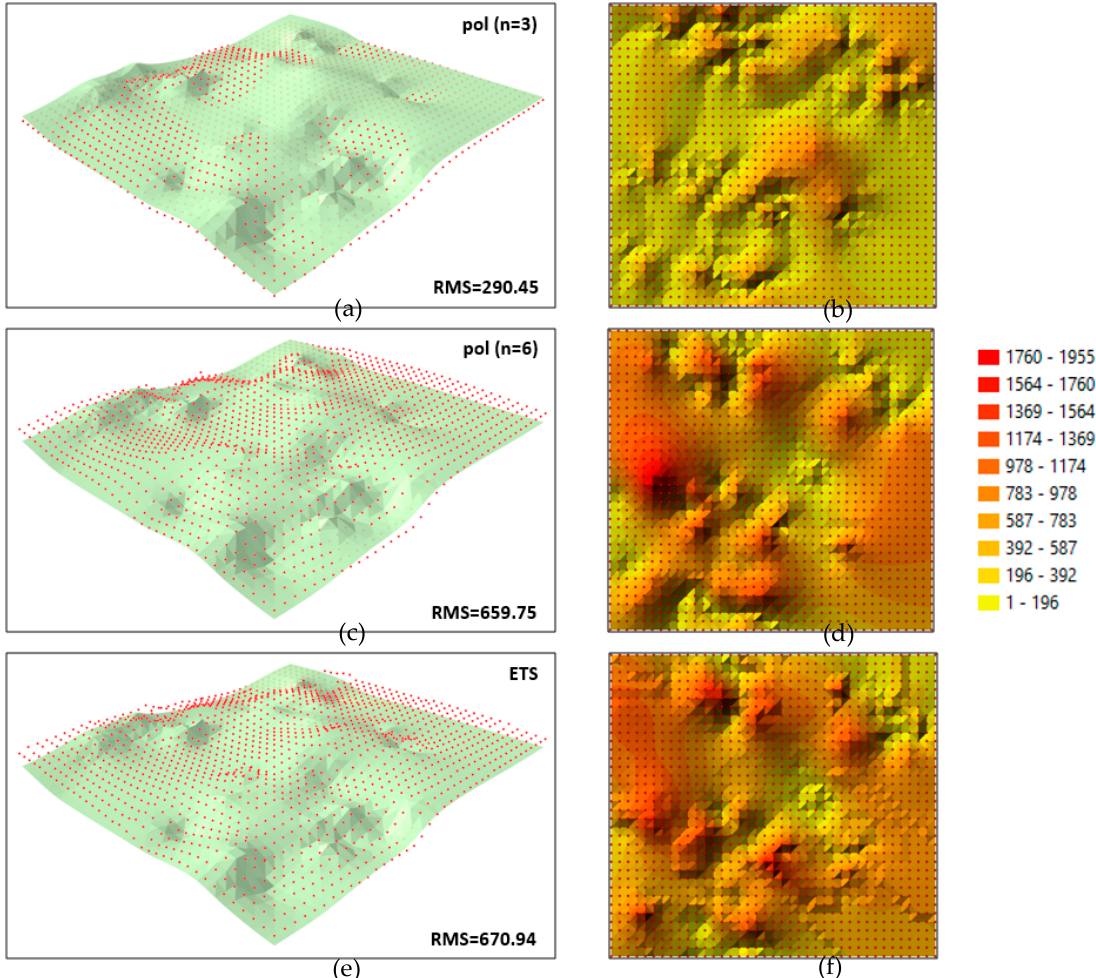
Figure 8. A comparison of the accuracy with which the forecast nodes of the GRID structure were fit to the original surface with the use of various methods in the absence of the 2012 epoch: ( a ), ( c ), ( e )—original surface and forecast nodes; ( b ), ( d ), ( f )—differential diagrams. Source: own elaboration.